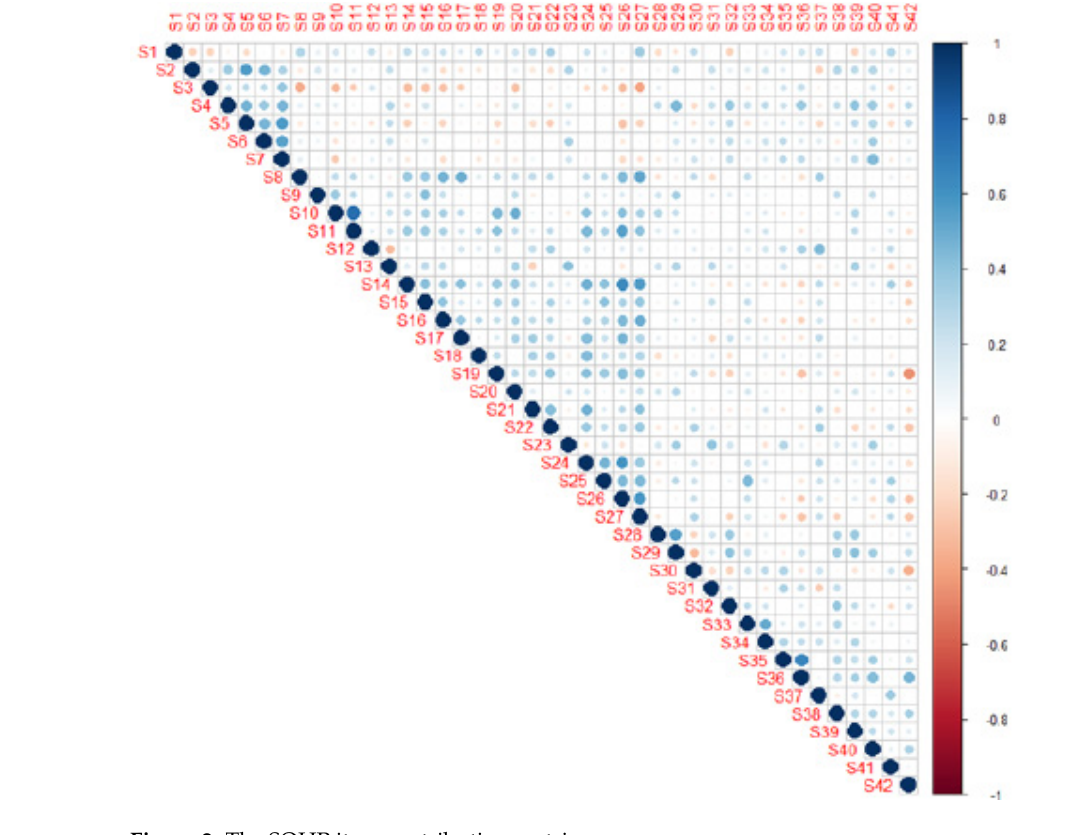
Figure 2. The SOHP item contribution matrix.